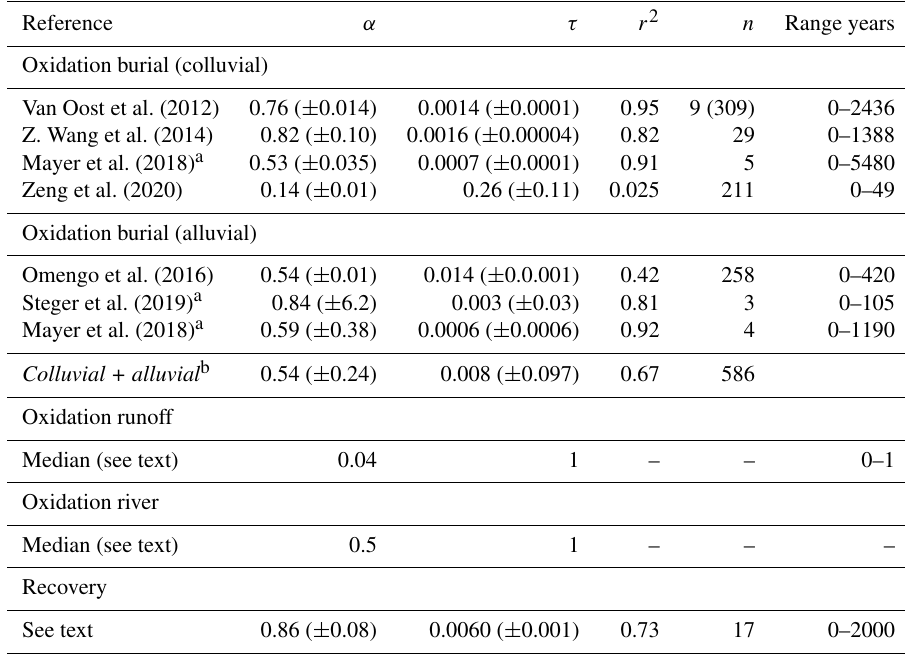
Table 2. Estimates of α and τ reported in the literature. Estimates are derived from a non-linear regression using Eq.